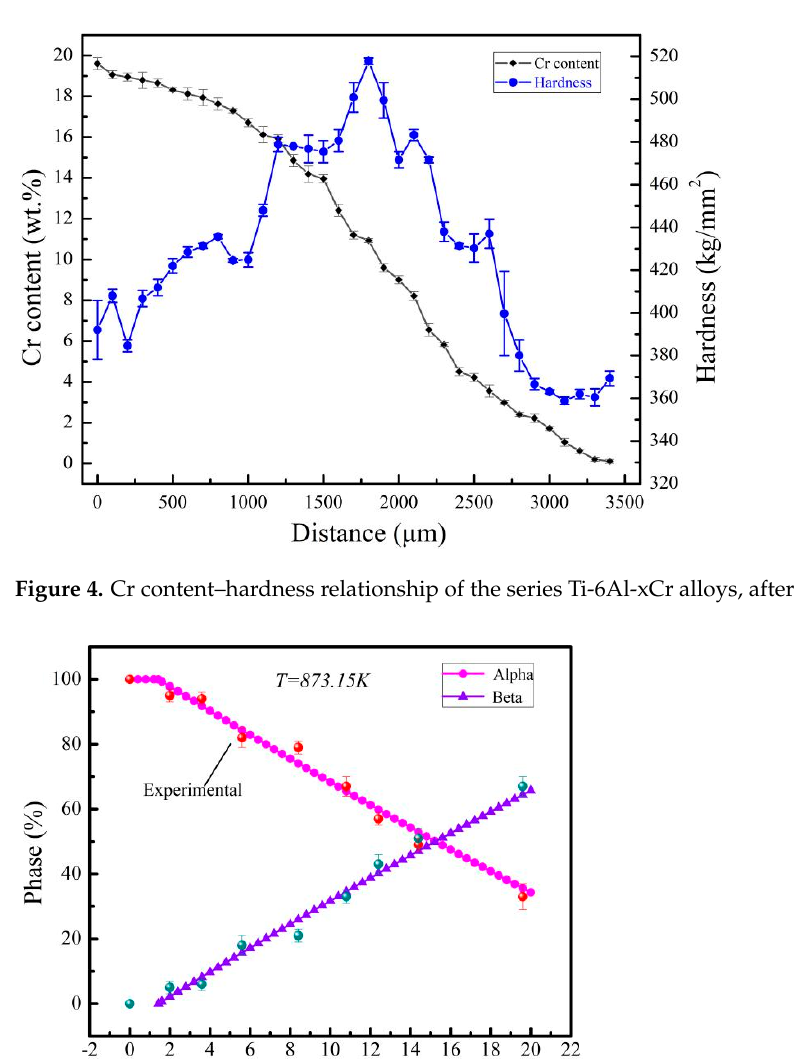
Figure 5. The calculation results of the phase composition of Ti ‐ 6Al ‐ xCr alloys, after aging at 600 °C.